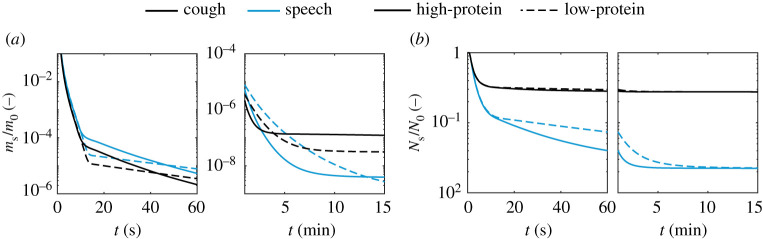
Time evolution of (a) total mass and (b) total droplet number, all normalized by their respective values at t = 0, in terms of the composition: low protein (sputum 9 mg ml−1 NaCl, 3 mg ml−1 protein) and high protein (sputum 9 mg ml−1 NaCl, 76 mg ml−1 protein)–T = 20°C, RH = 60%. (Online version in colour.)